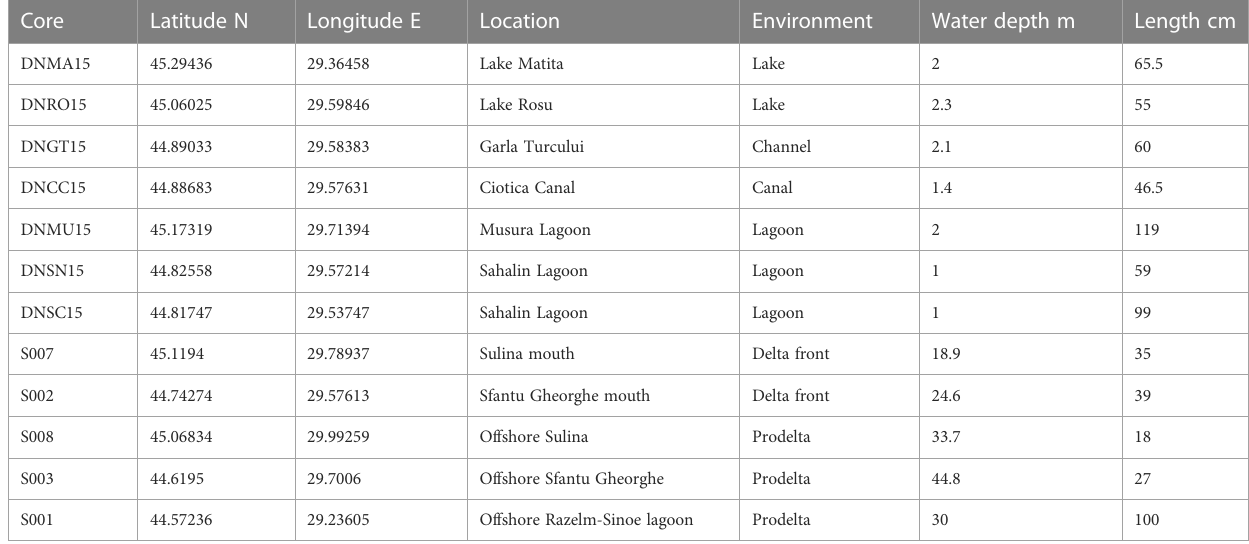
TABLE 1 Key parameters of the sedimentary cores analysed in this study, including name, geographical position, geographic location, physiography, water depth and length. Core Latitude N Longitude E